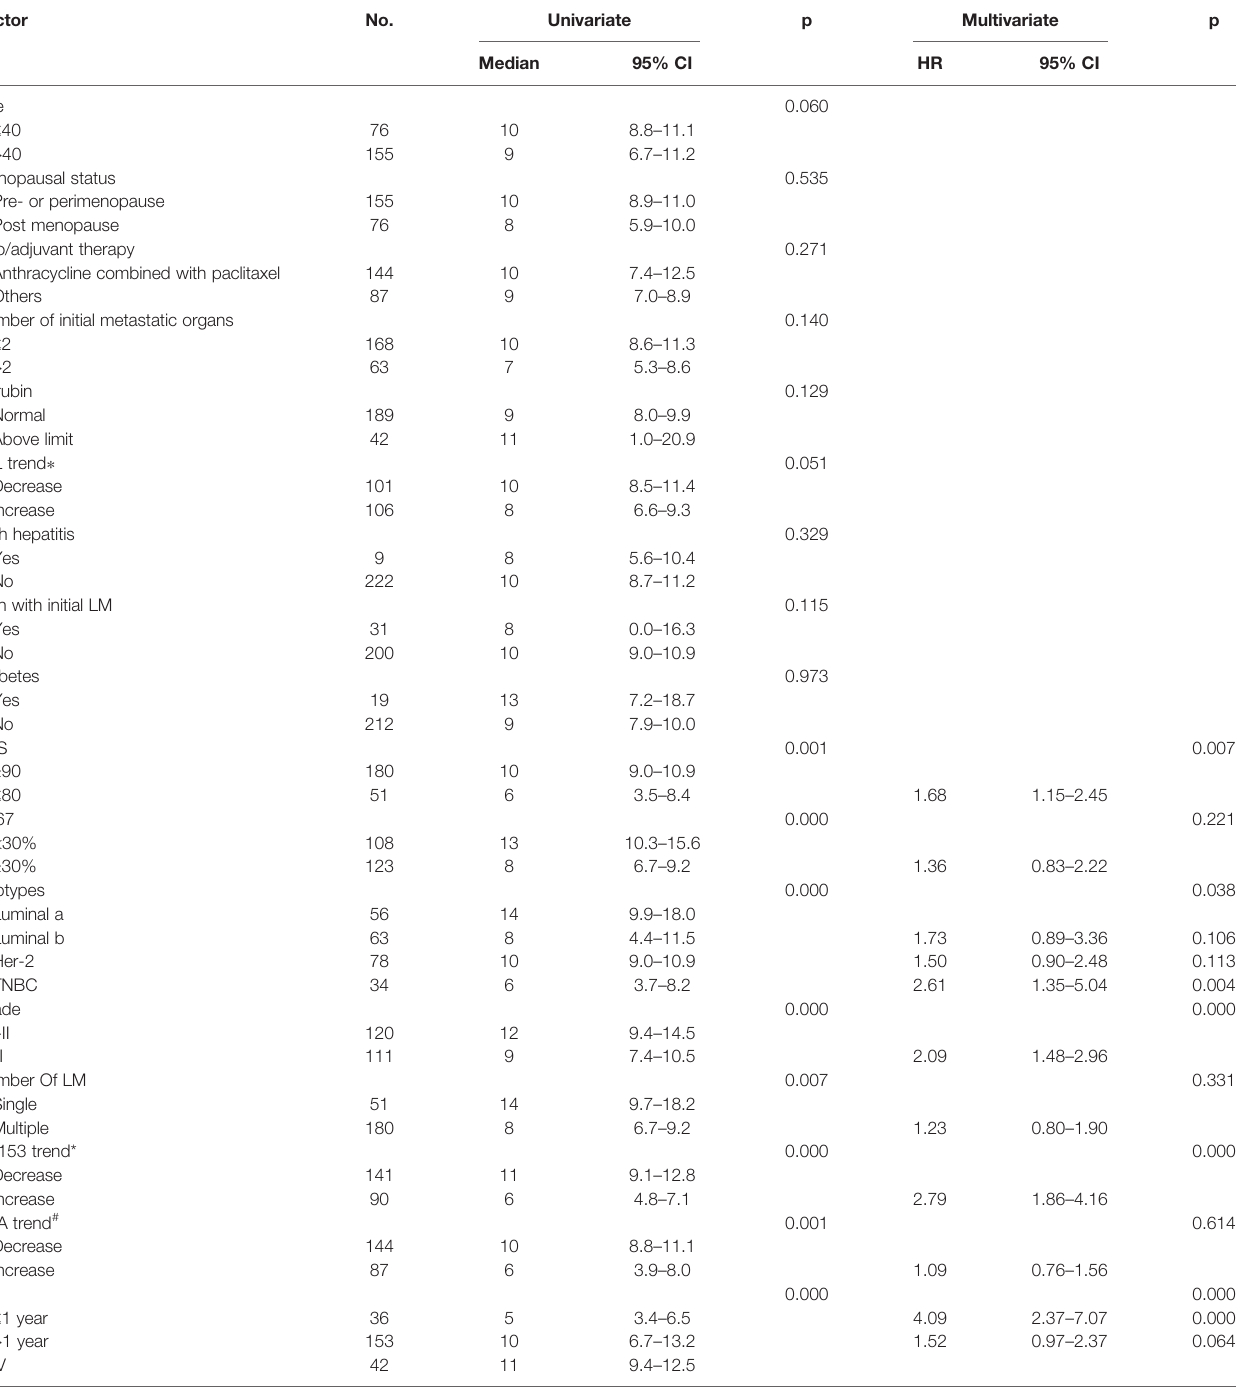
TABLE 2 | Univariate and multivariate models for PFS with BCLM patients (n = 231). Factor No. Univariate p